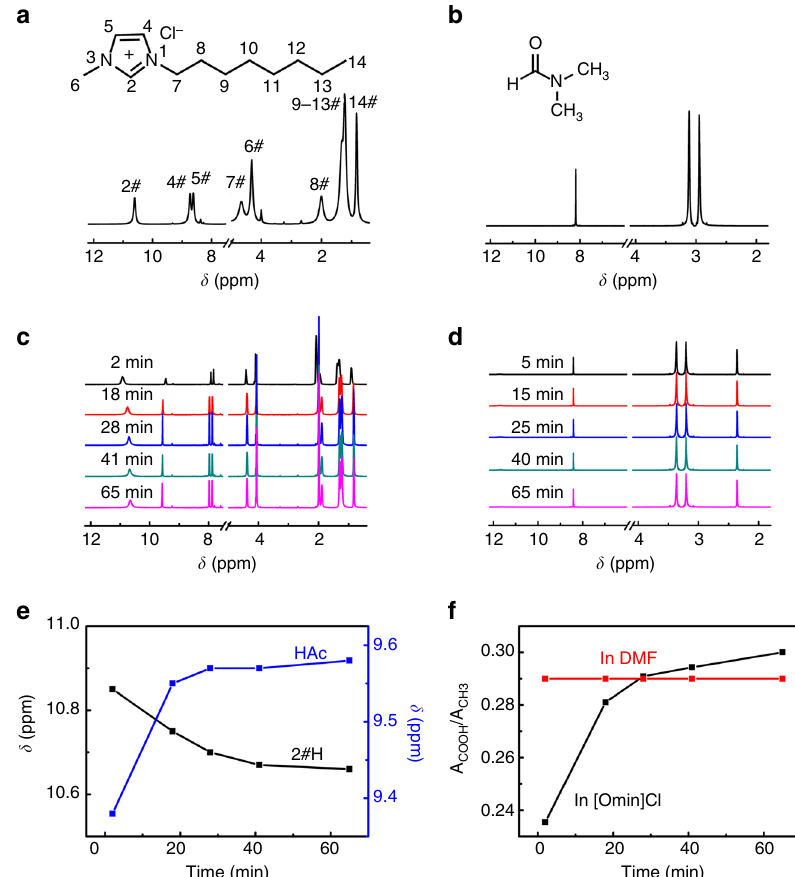
Fig. 2 1 H NMR spectra of [Omim]Cl, DMF and UiO-66 synthesis mixtures. a , b Molecular structures and 1 H NMR spectra of [Omim]Cl and DMF, respectively. c , d In situ 1 H NMR spectra of the UiO-66 synthesis mixtures in [Omim]Cl and DMF at 298.2 K, respectively. e Chemical shift of 2#H in [Omim]Cl and active H in HAc of the UiO-66 synthesis mixtures in [Omim]Cl with reaction time. f A COOH /A CH3 of the UiO-66 synthesis mixtures in [Omim]Cl and DMF,